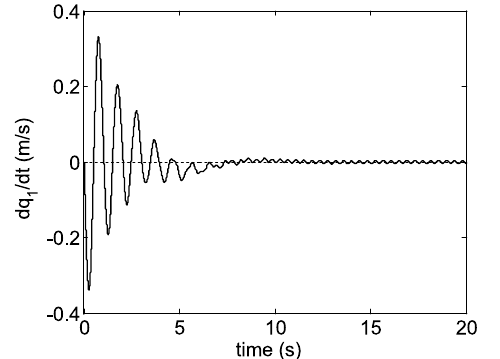
Fig. 14. Estimated behavior of variable ˙ q 1 considering different ini- tial conditions for the angular displacements.